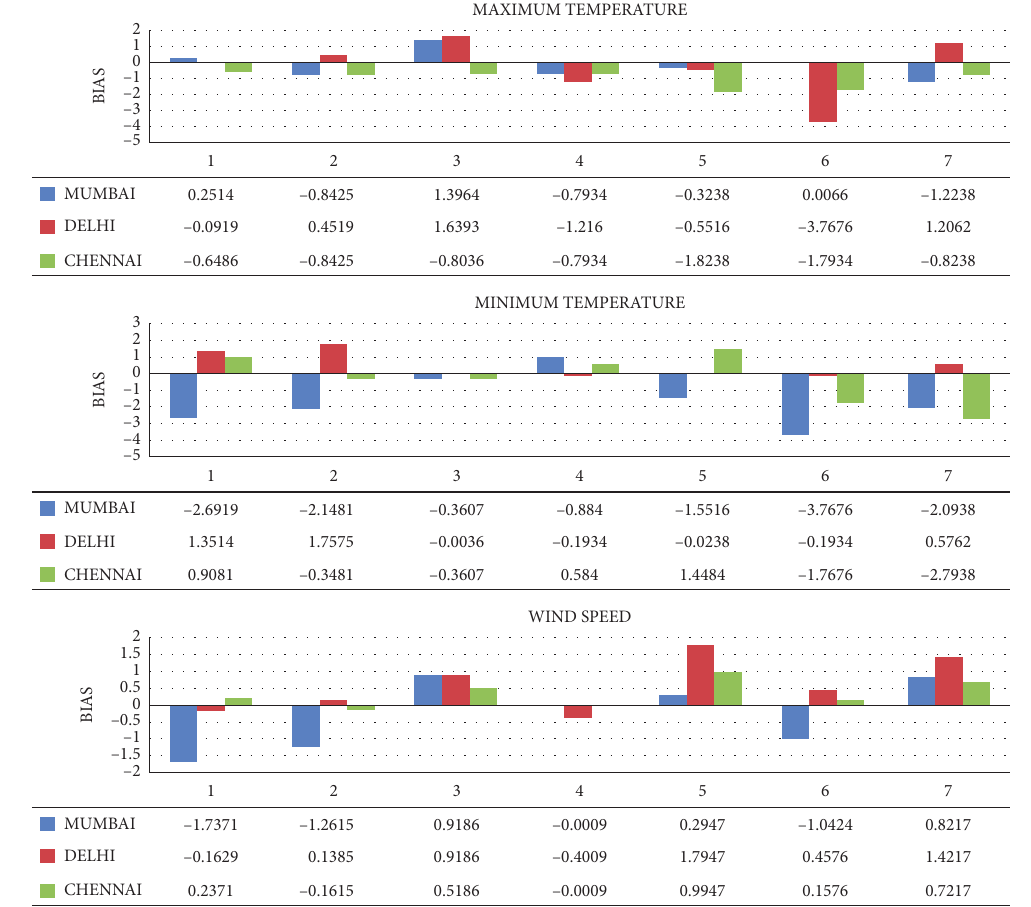
Figure 9: Bias of Delhi, Mumbai, and Chennai. (a) Maximum temperature. (b) Minimum temperature. (c) Wind